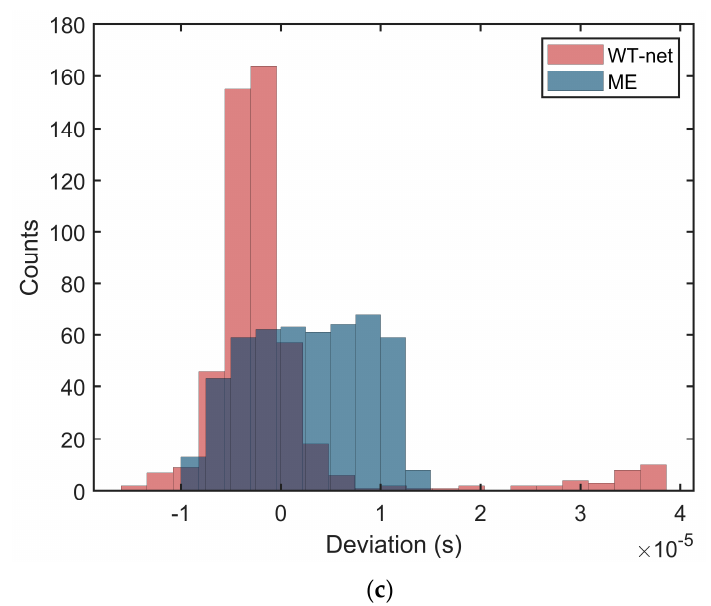
Figure 8. Deviations between the measured time and standard time under different SNRs by two methods: ( a ) 15 dB, ( b ) 10 dB, ( c ) 5 dB.